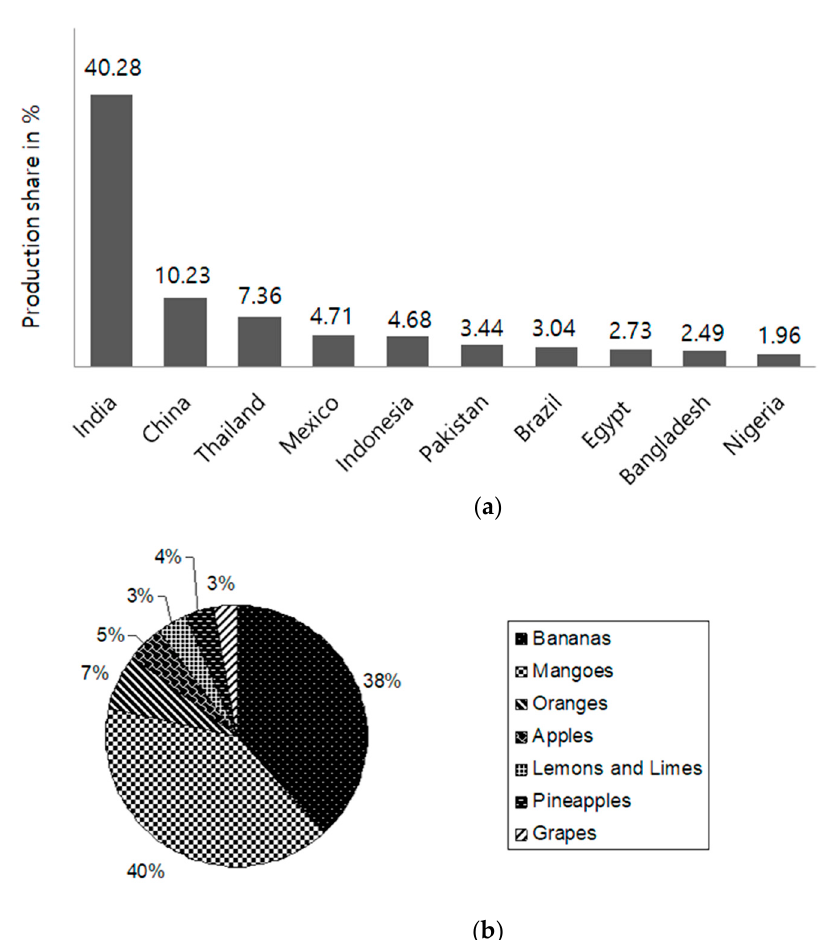
Figure 1. ( a ) Production share (%) of the top ten mango-producing countries in 2019–2020. ( b )